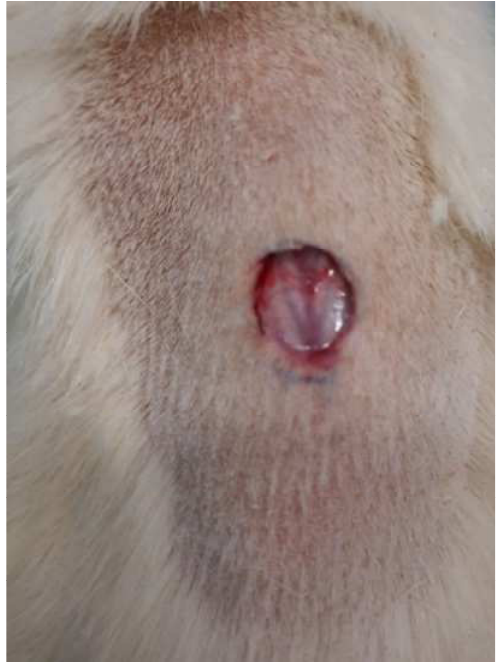
Figure 11. Excision wound on day 0.